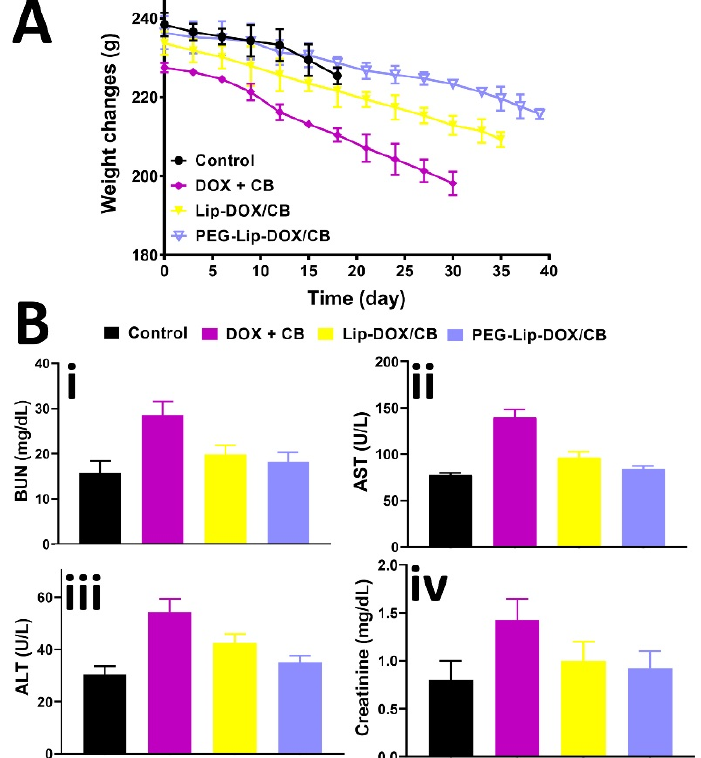
Figure 5. ( A ) Weight changes in brain-tumor-bearing rats in DOX + CB, Lip-DOX/CB, and PEG-Lip-DOX/CB receiver groups at three-day intervals and for 39 days after tumor cell inoculation and ( B ) serum concentrations of ( i ) alanine aminotransferase (ALT), ( ii ) aspartate aminotransferase (AST), ( iii ) BUN, and ( iv ) creatinine in DOX + CB, Lip-DOX/CB, and PEG-Lip-DOX/CB receiver glioblastoma-bearing rats compared to the control group. Table 6. Histological evaluation of organ toxicity in brain-tumor-bearing rats after treatment with DOX + CB, Lip-DOX/CB, and PEG-Lip-DOX/CB, compared to the control group. Number of Animals Organ Score Control